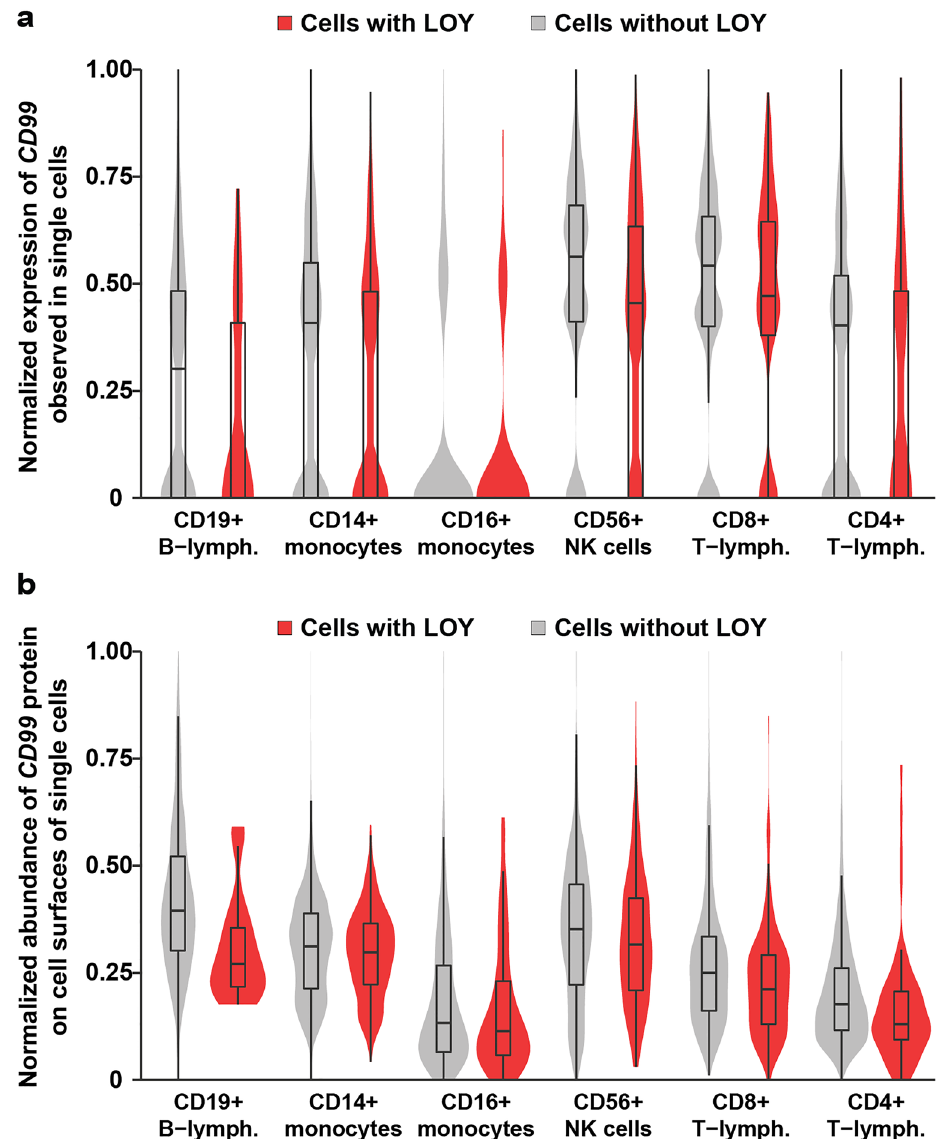
Figure 2. CITE-seq results illustrating a reduced abundance of CD99 analytes in single cells with LOY. The measurements of mRNA and protein abundances displayed on the Y-axes in panels ( a ) and ( b ) were linearly adjusted on a scale between 0 and 1 before plotting, to increase interpretation and comparability between cell types. Overlapping violin- and box-plots were used to illustrate the distributions of CD99 derived mRNA